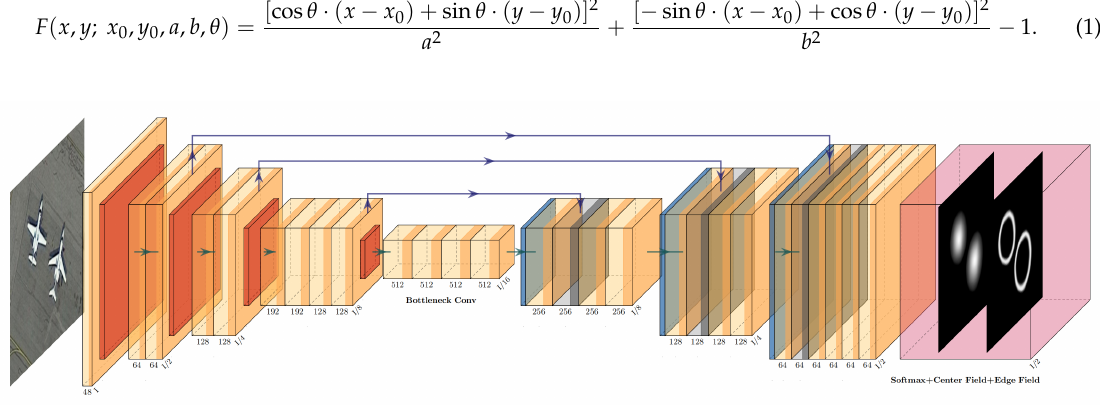
Figure 3. Visualization of the network architecture. In the input image, the target to be detected is two airplanes. The output of the network is two fields describing the distribution probability of the center and edge of the target. The input passes through some convolutional and pooling layers to extract features. Then, through several concatenations, convolutions, and bilinear interpolations, the output results are